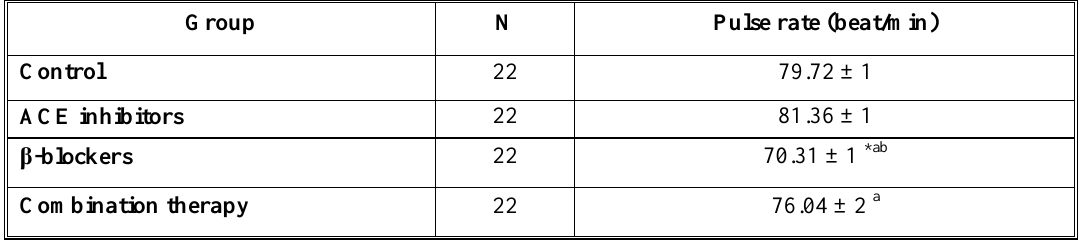
* P ≤ 0.05 significant difference from the control. a P ≤ 0.05 significant difference from the ACE inhibitors treated group. b P ≤ 0.05 significant difference from the Combination therapy treated group. Table 11: CHD risk % and stroke % based on SBP in control healthy individuals and non diabetic hypertensive patients treated with different antihypertensive drug regimens. Each value represents mean± standard error of mean.